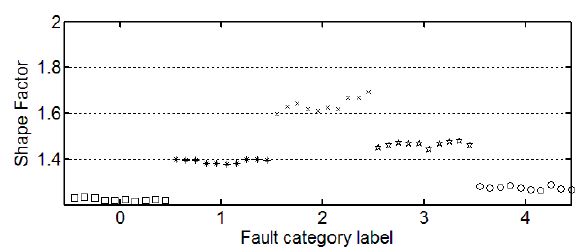
Figure 2. The trend of absolute mean.